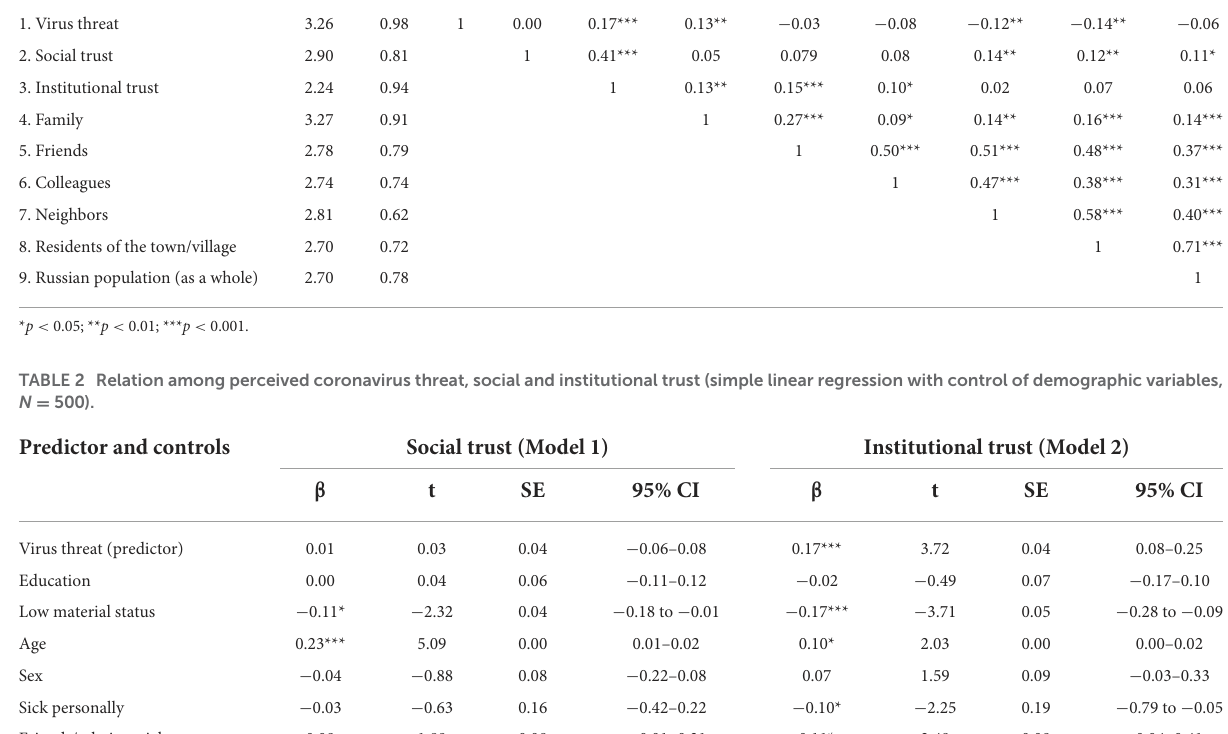
TABLE 1 Descriptive statistics and correlations between variables. Variable